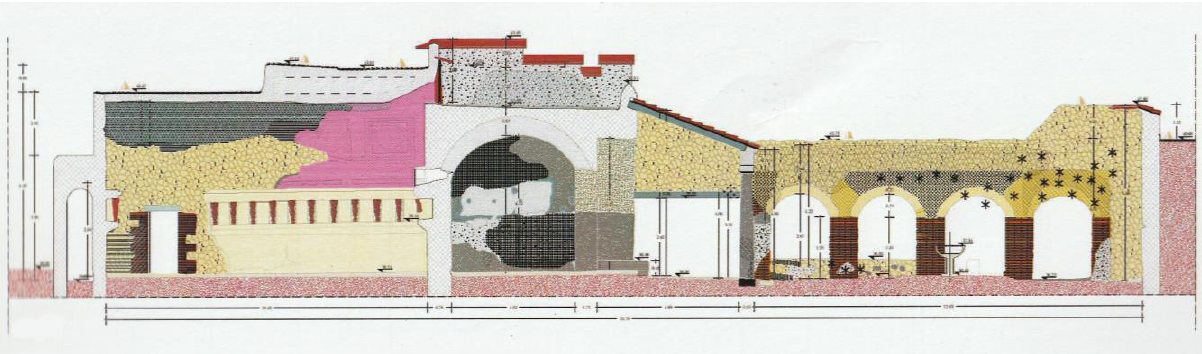
Figure 3. Forum Baths, longitudinal section with the analysis of the state of conservation of stone surfaces (Cicirelli, Brancaccio, Mangone, 2018).